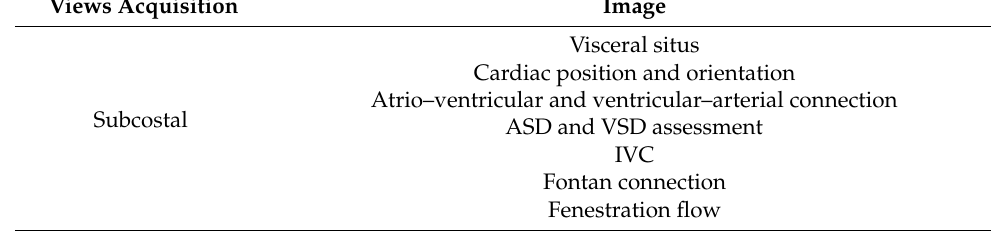
Table 1. Fontan patients’ echocardiographic